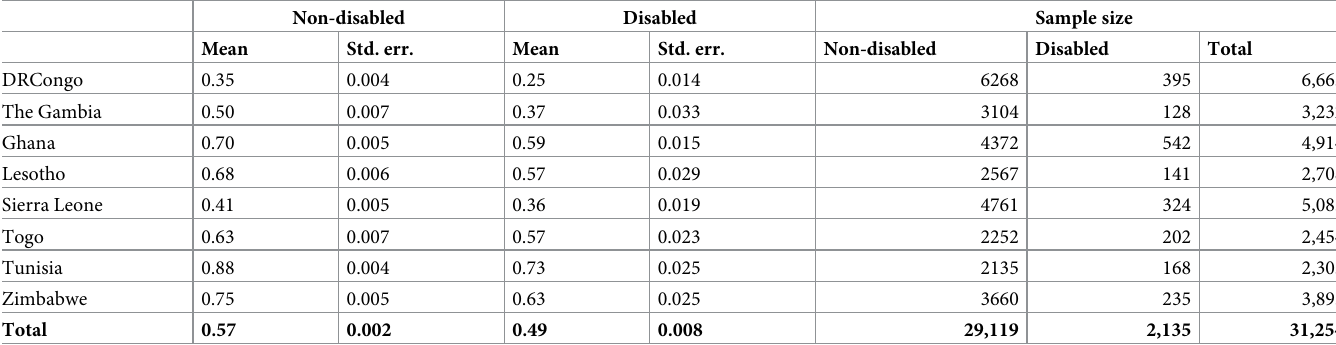
Table 2. Mean numeracy score by countries. Non-disabled Disabled Sample size Mean Std. err. Mean Std. err. Non-disabled Disabled